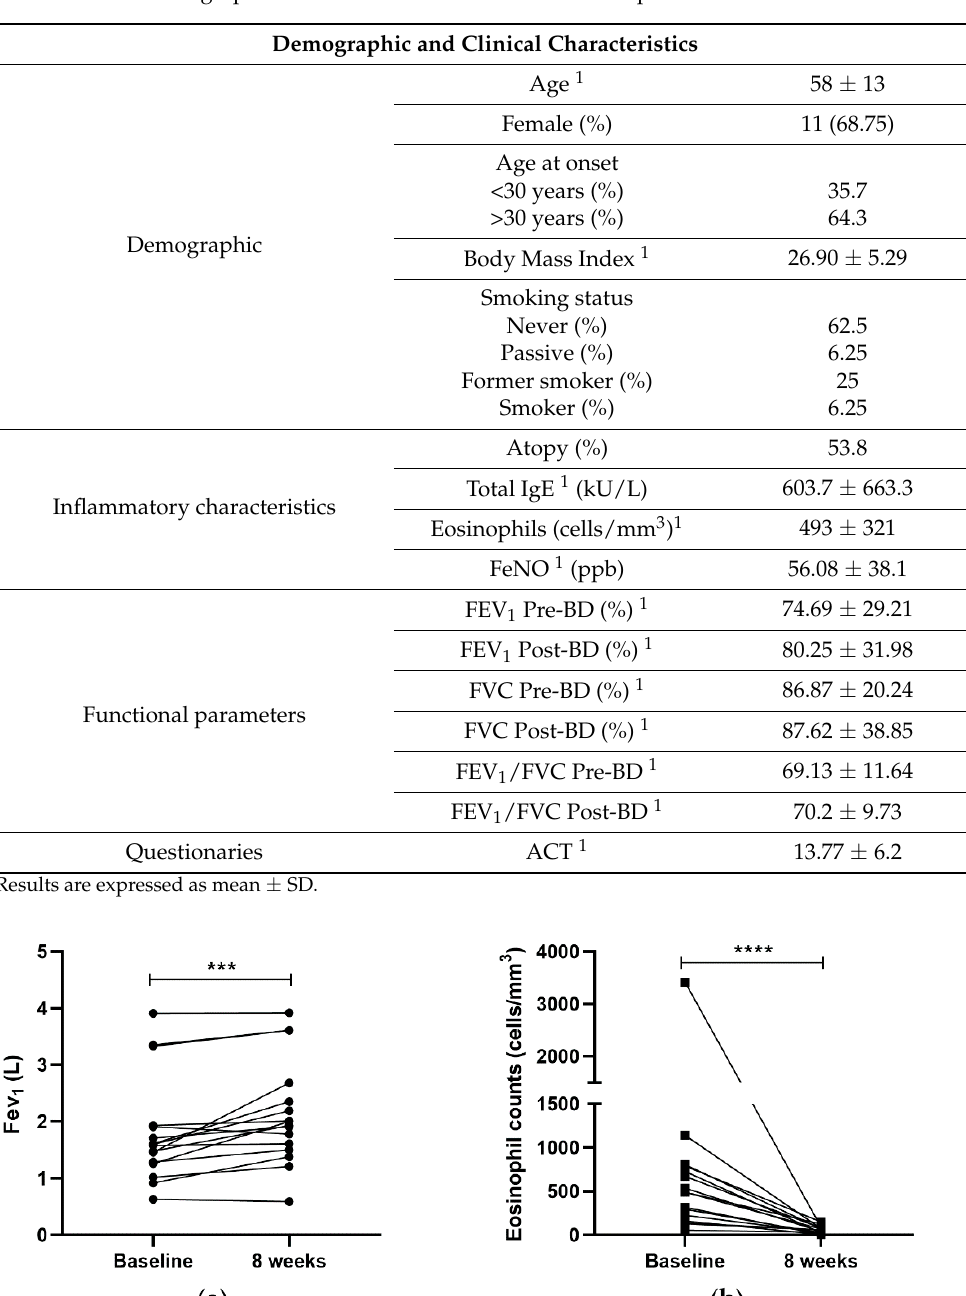
Table 1. Initial demographic and clinical characteristics of the 16 patients.